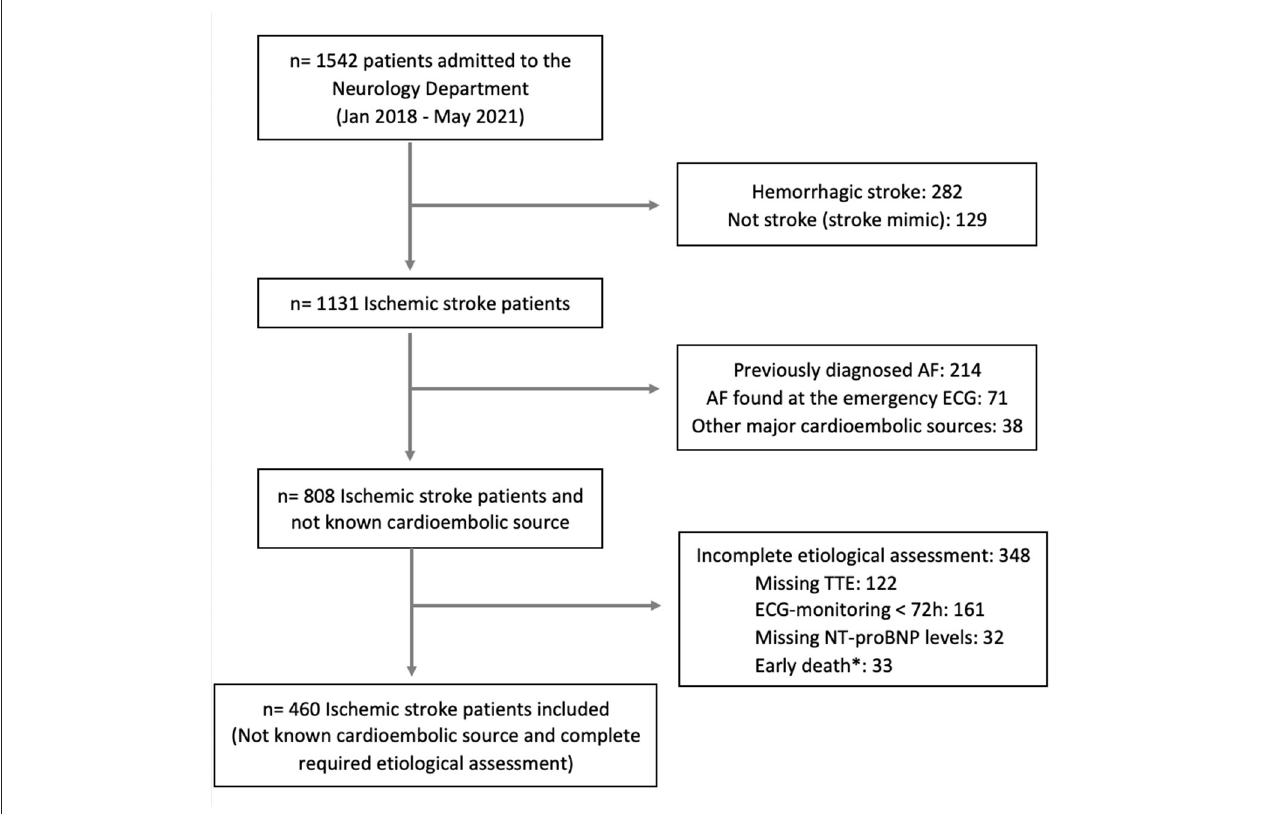
FIGURE 1 | Study flowchart showing the patient selection process. *Incomplete assessment due to death within the first 72h after admission, AF, atrial fibrillation; NT-proBNP, N-terminal prohormone of brain natriuretic peptide; TTE, transthoracic